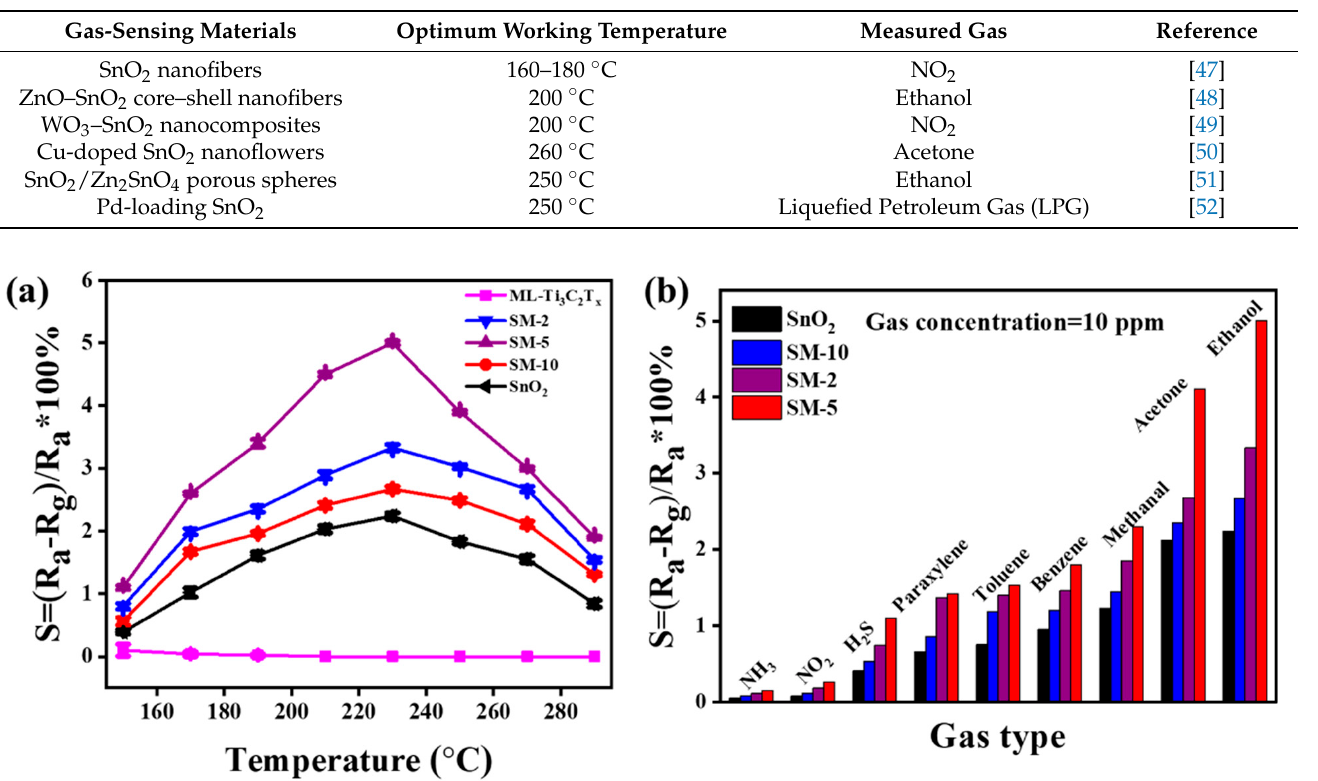
Figure 5. Gas-sensing properties of SnO 2 microspheres and their composites. ( a ) Response sensitivity to 10 ppm ethanol at different temperatures; ( b ) Response value to 10 ppm different gases at the optimal working temperature of 230 °C.